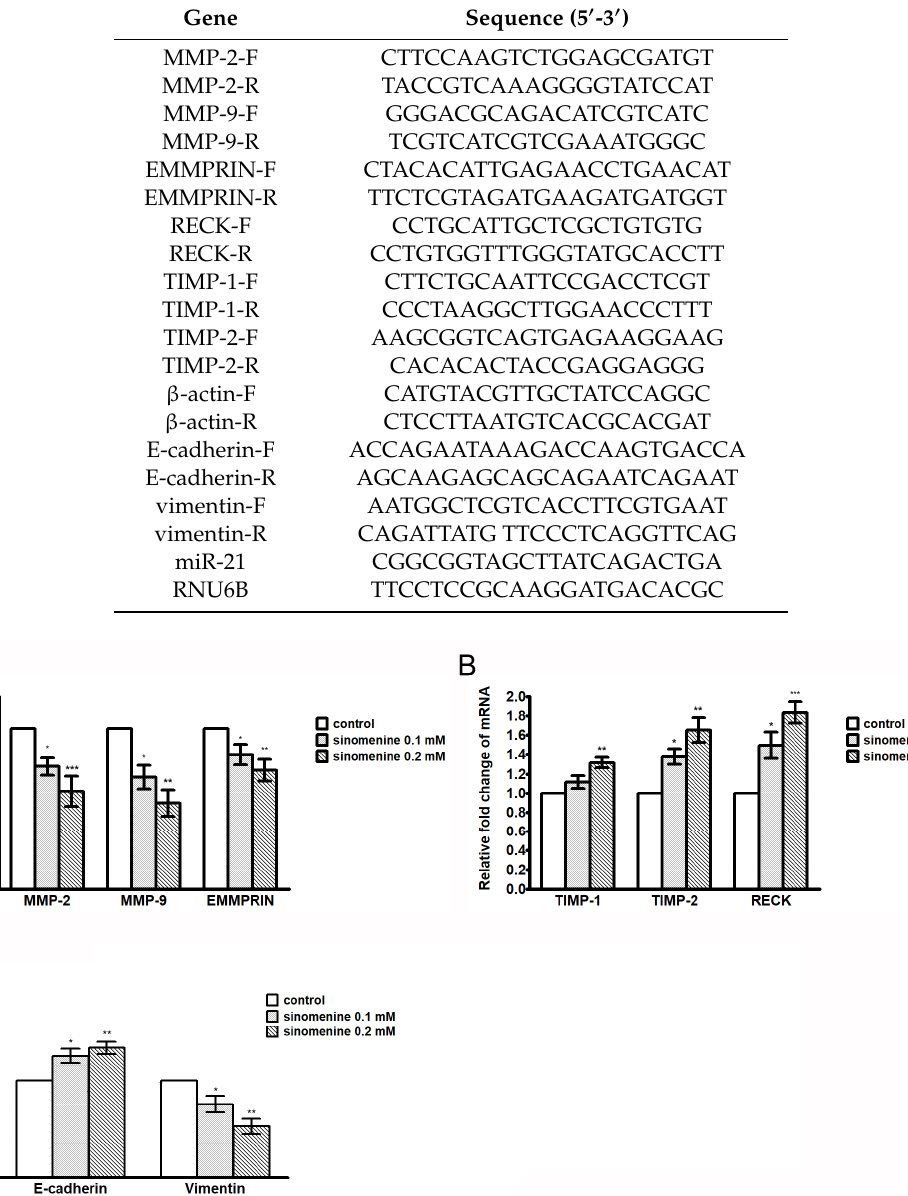
Table 1. Primer pairs used in quantitative real-time PCR.